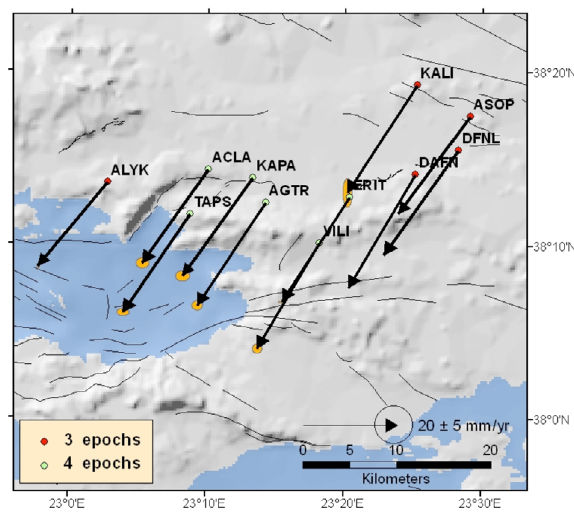
Figure 5. KAPNET station vectors for horizontal velocity from analysis described in the main text. Velocity reference frame is fixed to the stable interior of the Eurasia plate (Figure 3b). Error ellipses represent 95% confidence regions. Grey lines are active faults [Ganas et al. 2013b].